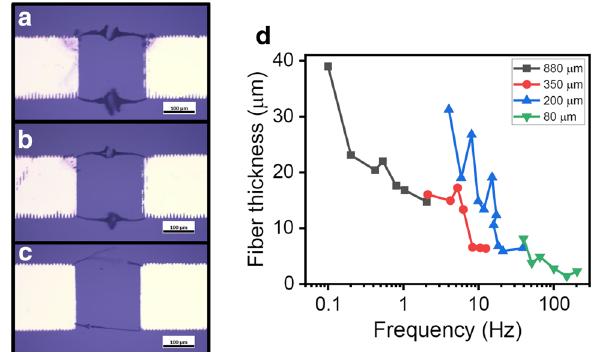
Fig. 3 Fibers grown at dif- ferent frequencies: 5 Hz ( a ), 10 Hz ( b ), and 20 Hz ( c ). Fiber thickness measured at differ- ent electrodes spacings ( d